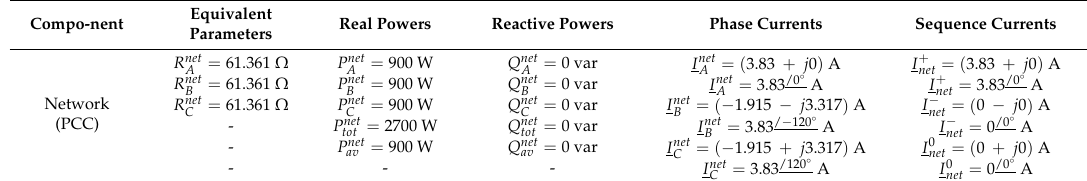
Table 4. Load-compensator assembly seen at source (in the PCC)—values valid for both